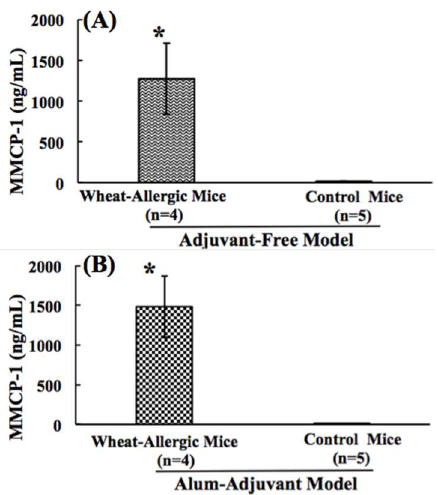
Figure 5. ( A , B ). Comparison of the mucosal mast cell protease-1 responses in the adjuvant-free vs. the alum-adjuvant mouse models. ( A ) In the AF model, Balb / c mice were exposed to SSWP once a week for 6 weeks via the transdermal route, as described in the methods. A group of control mice did not receive this exposure. Plasma collected at 1 h after the challenge with SSWP was used in the MMCP-1 protein analysis using an ELISA method described previously [42]. Figure shows the MMCP-1 levels in allergic mice vs. the control mice in the AF model. ( B ) In the AA model, Balb / c mice were injected with SSWP along with alum by the intraperitoneal route, as described in the methods. A group of control mice received alum only for the injection. Plasma collected at 1 h after the challenge with SSWP was used in the MMCP-1 protein analysis using an ELISA method described previously [42]. Figure shows the MMCP-1 levels in allergic vs. control mice in the AA model. * Student’s t test, p < 0.05.